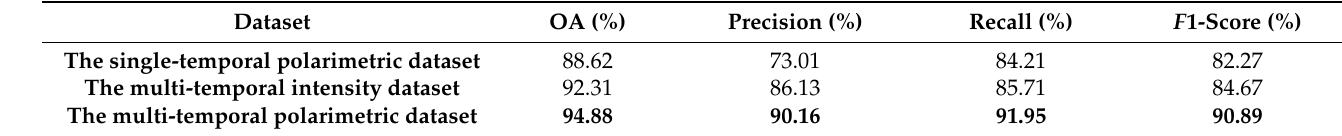
Figure 9. The classification results of RIAU-Net for the different 2020 datasets. ( a ) The Sentinel-1 SAR images. ( b ) The label images. ( c ) The single-temporal polarimetric dataset. ( d ) The multi-temporal intensity dataset. ( e ) The multi-temporal polarimetric dataset. Table 4. Results for the RIAU-Net model trained by the different datasets.